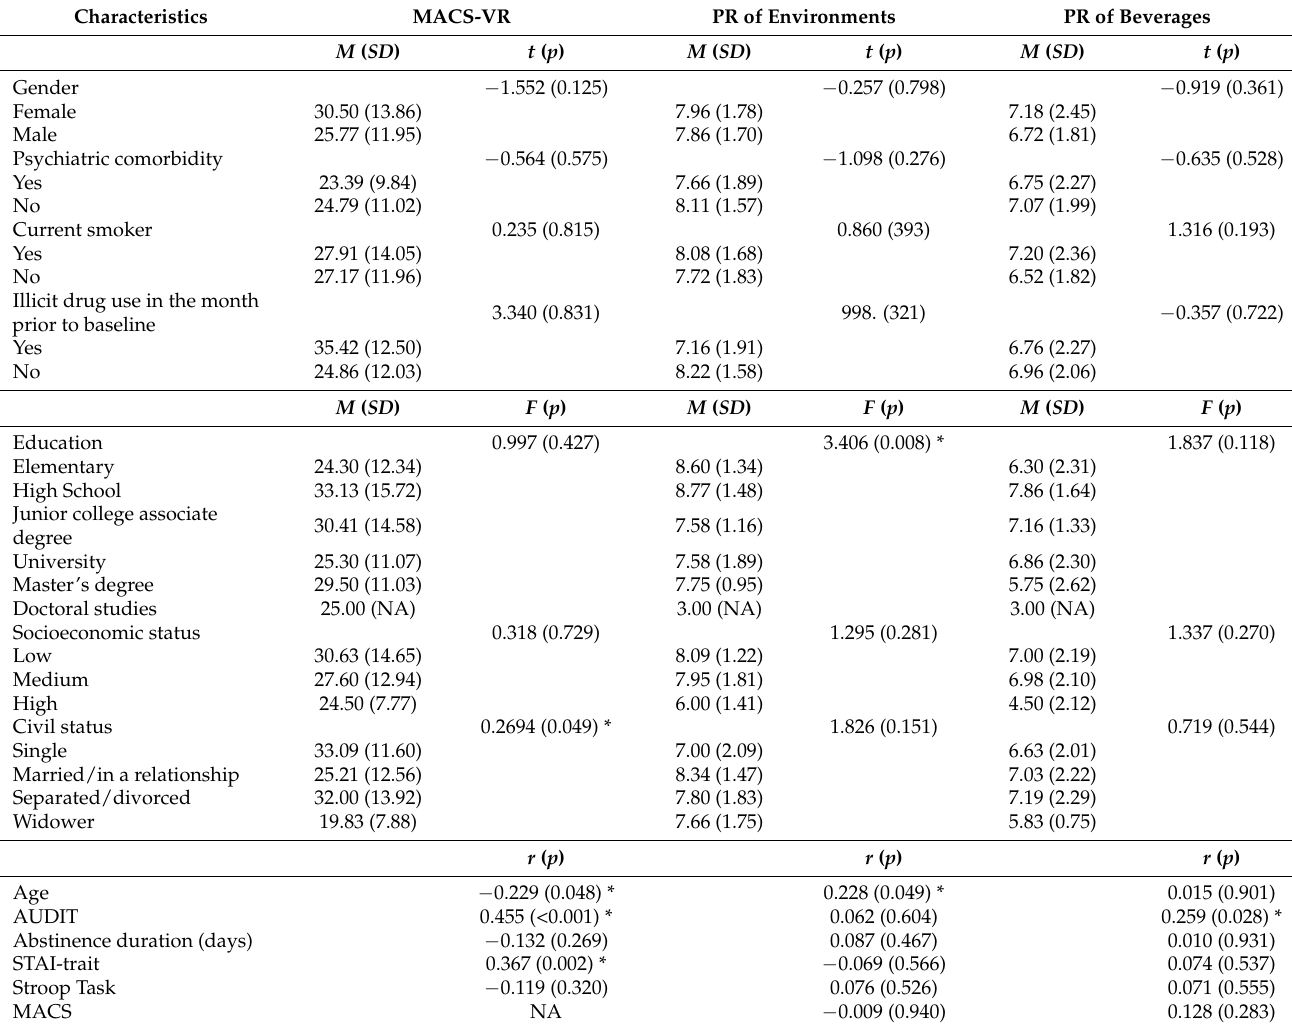
Table 2. The relationship between sociodemographic, psychological and consumption characteristics with MACS-VR, PR of environments and PR of beverages.